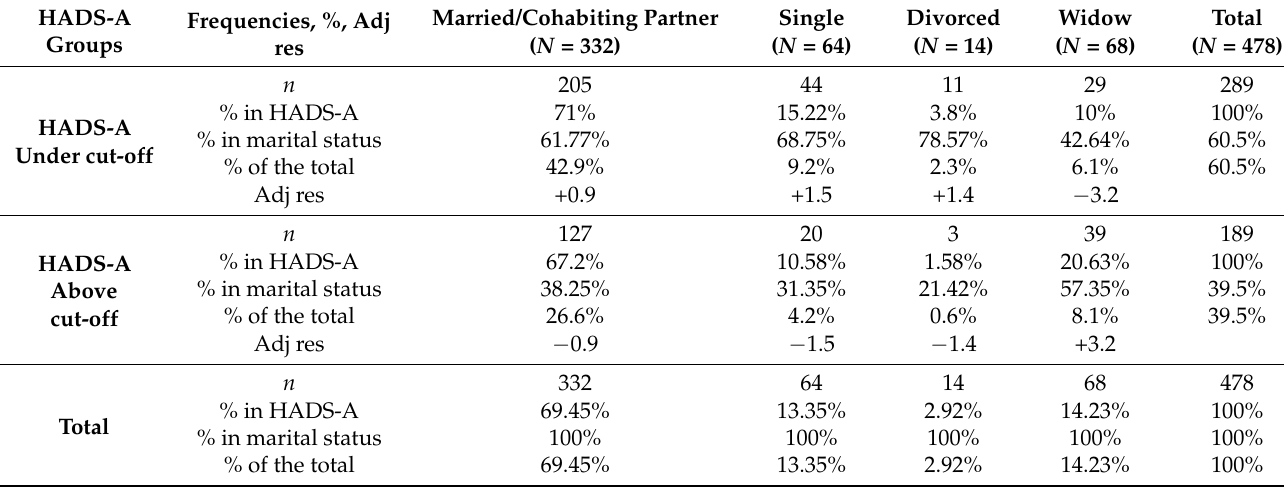
Table 2. Contingency table with frequencies of patients above/under the HADS-A cut-off scores and the marital status. HADS-A Groups